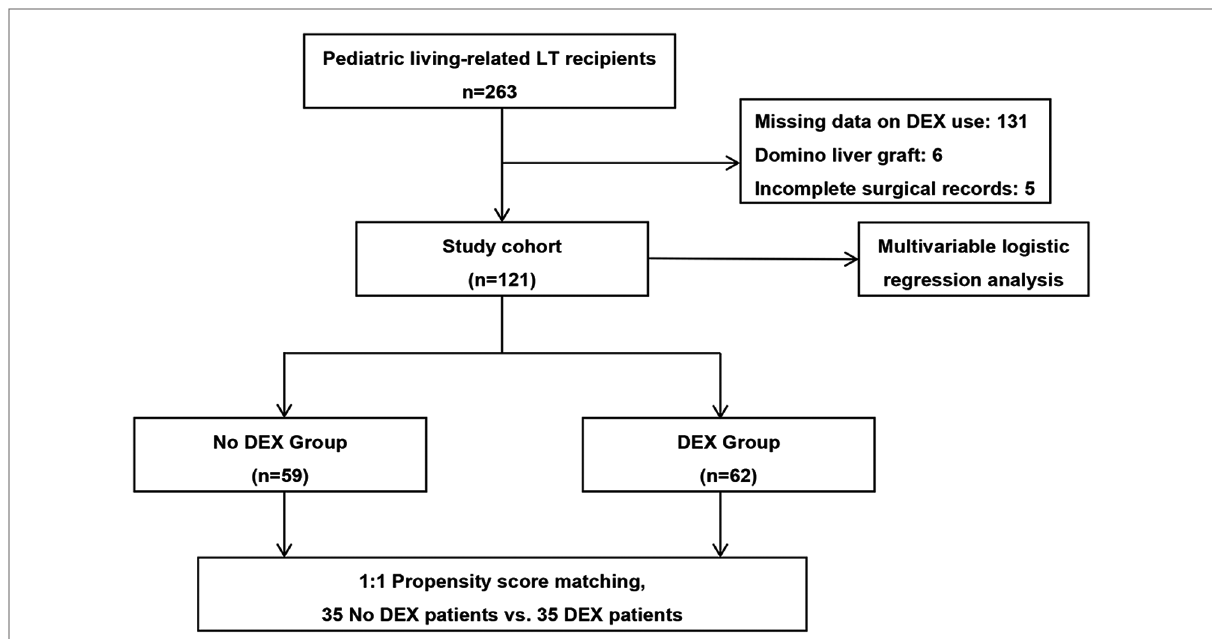
FIGURE 1 Patient and analysis fl owchart. Of the patients, 142 were excluded due to missing data related to DEX use, implanted with a domino liver graft, or incomplete surgical records. DEX, dexmedetomidine; LT, liver